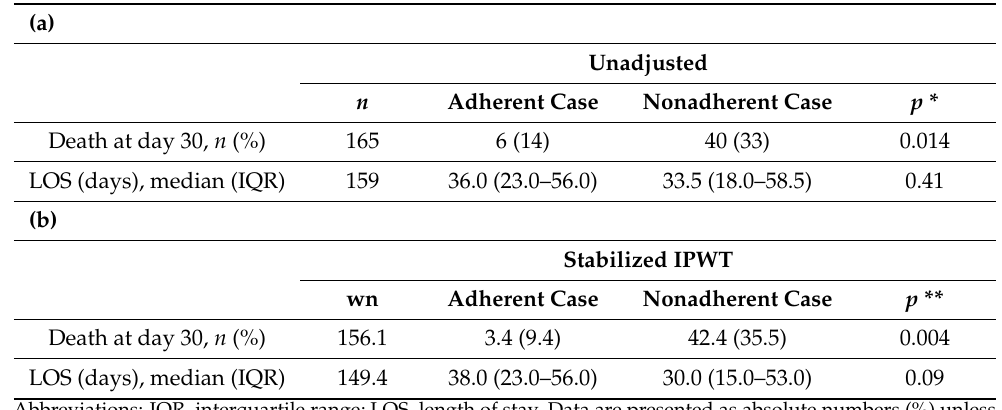
Table 4. Unadjusted (a) and stabilized IPWT (b) analysis of outcome associated with ESCMID